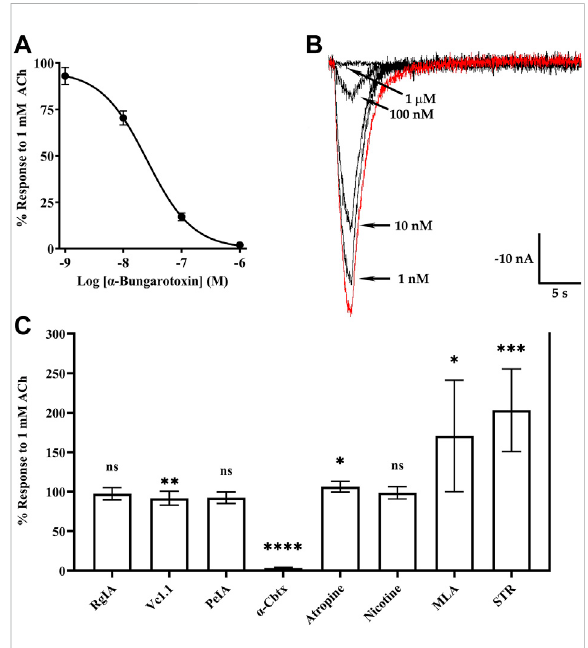
FIGURE 7 Currents evoked by acetylcholine (ACh; 1 mM) from oocytes expressing human α 10 nAChRs are potently inhibited by α -Bgtx and α -Cbtx. X. laevis oocytes were injected with cRNA encoding human α 10subunits andincubatedfor3 – 5 daysinfrogsaline containing MLA (20 μ M) or STR (20 μ M) and assessed by voltage- clamp electrophysiology. (A) α -Bungarotoxin inhibited ACh- evoked responses with an IC 50 of 21 (19 – 24) nM and the Hill slope was − 1.0( − 1.1to − 0.9)(n=5). (B) Currenttracesshowinginhibition of ACh-evoked currents by α -Bgtx; the trace in red indicates